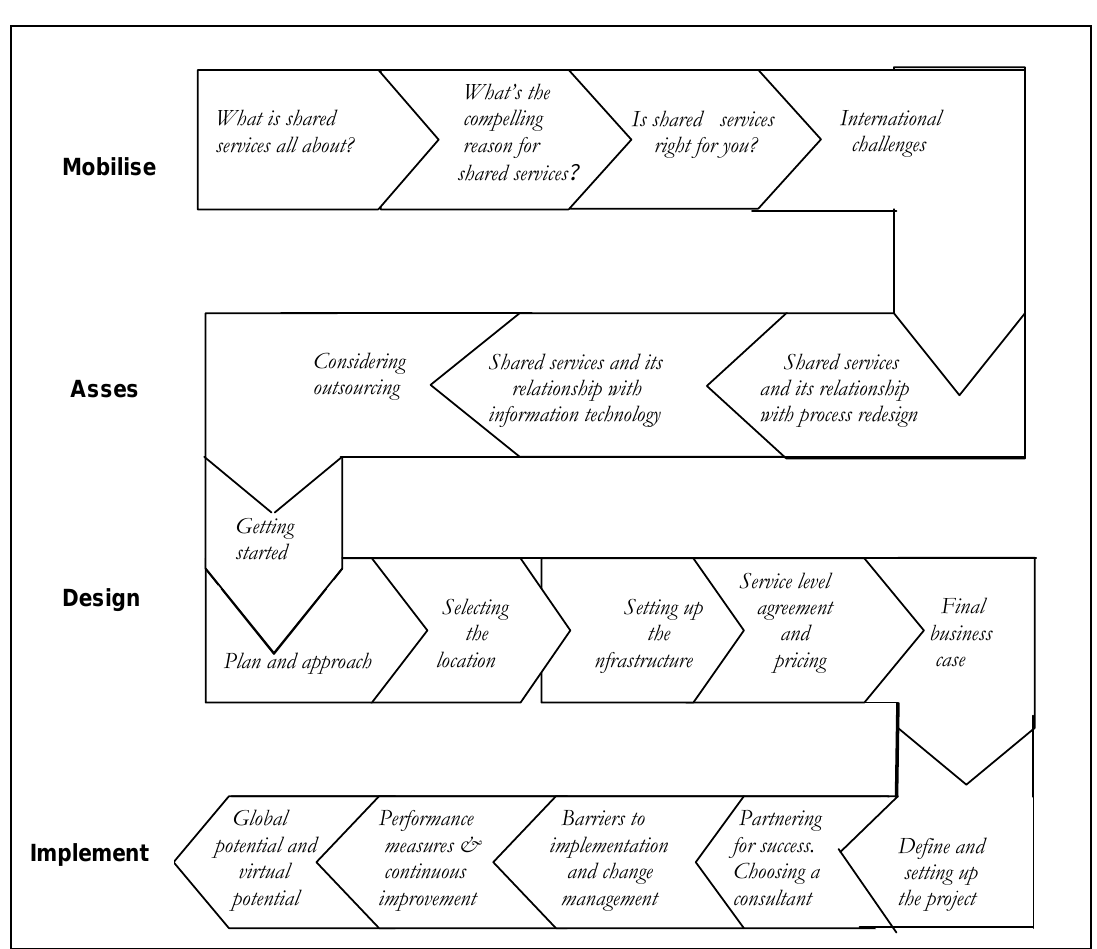
Figure 1: Road to shared